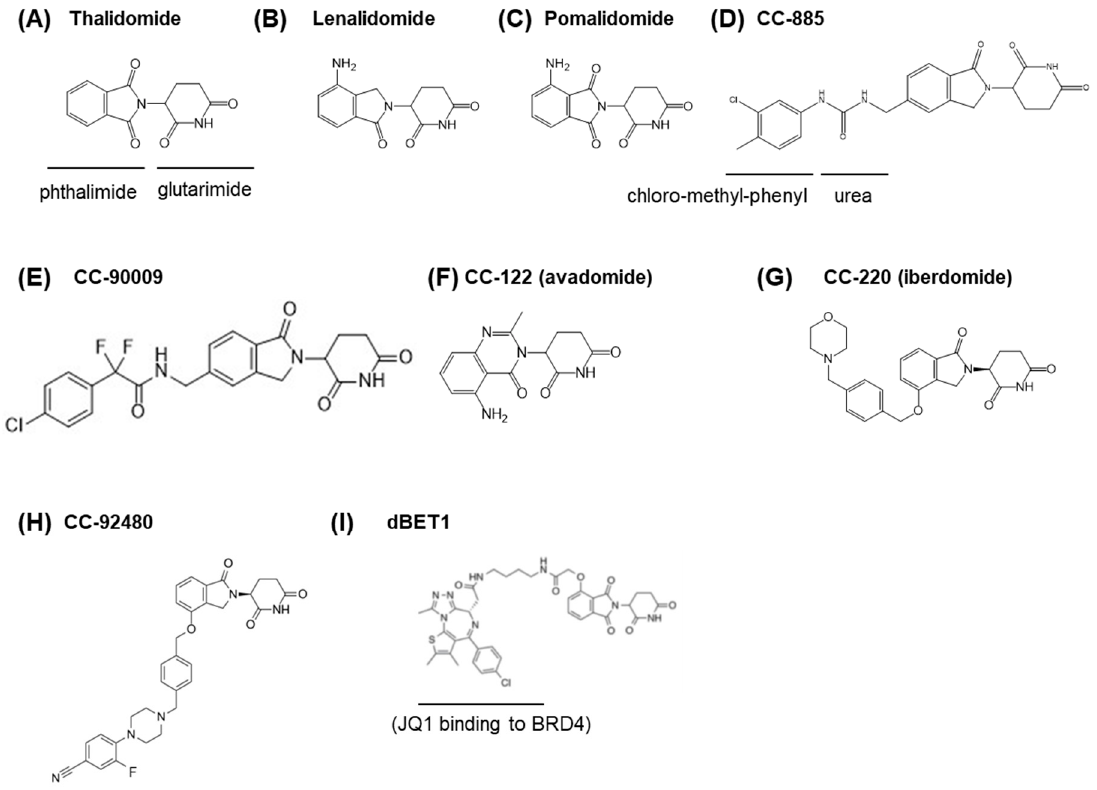
Figure 1. Structure of CRBN-binding drugs. ( A ) Thalidomide. ( B ) Lenalidomide. ( C ) Pomalidomide. ( D ) CC-885. ( E ) CC-90009 ( F ) CC-122. ( G ) CC-220. ( H ) CC-92480. ( I ) dBET1, composed of JQ1 (a BRD4 inhibitor) and thalidomide.